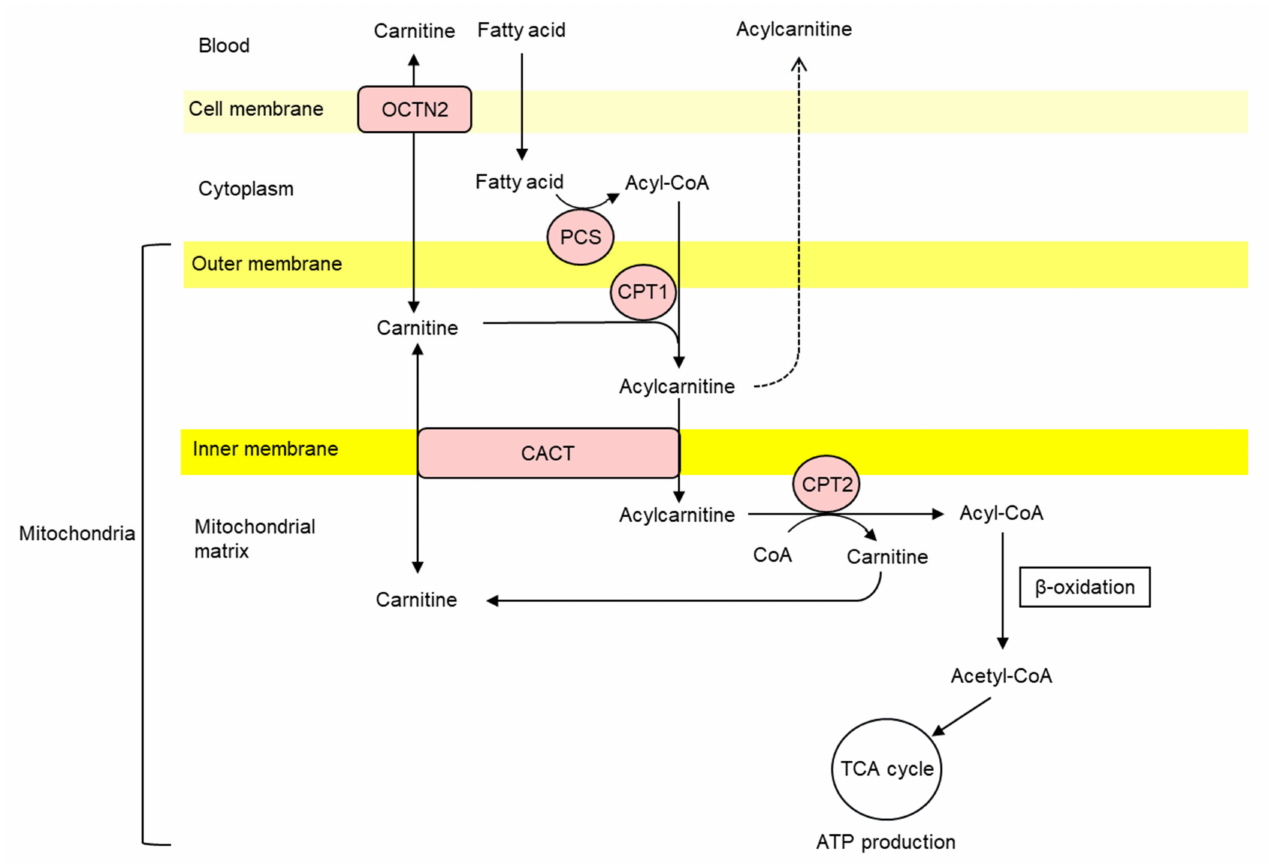
Figure 1. Fatty acid metabolism and metabolic functions of carnitine. CACT, carnitine acetyltransferase; CPT, carnitine palmitoyl transferase; OCTN2, organic cation/carnitine transporter 2, PCS, palmitoyl CoA